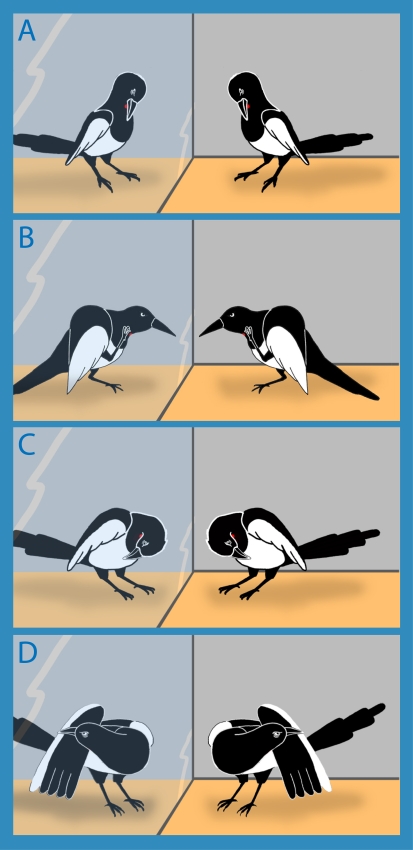
Examples of the Behaviors That Were Used for Quantitative Analysis(A) Attempt to reach the mark with the beak; (B) touching the mark area with the foot; (C) touching the breast region outside the marked area; (D) touching other parts of the body. Behaviors (A) and (B) entered the analysis as mark-directed behavior; behaviors (C) and (D) and similar actions towards other parts of the body were considered self-directed, but not related to the mark.